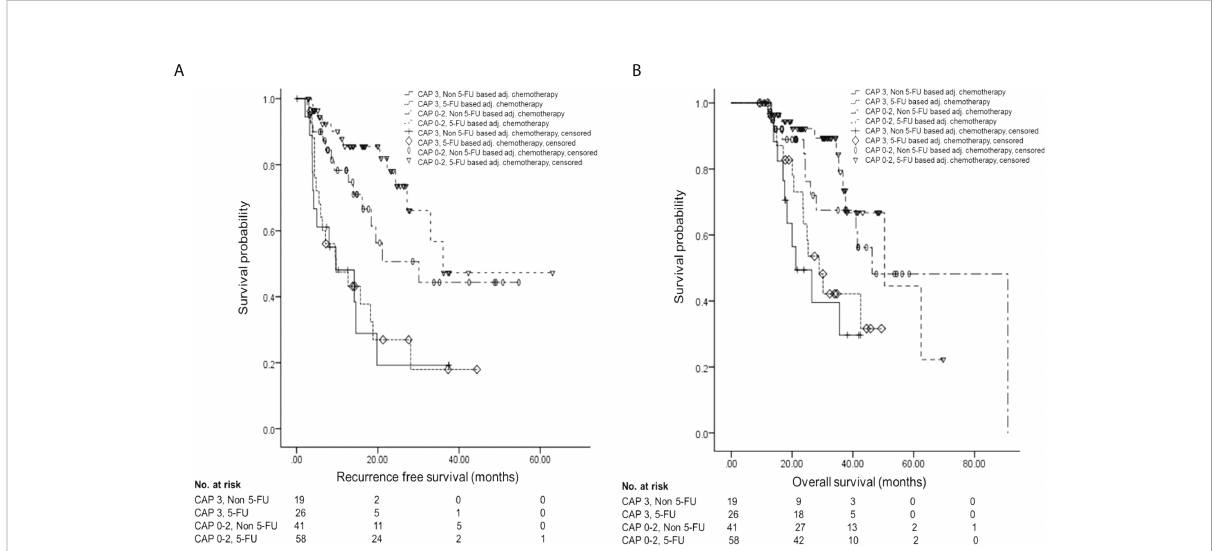
FIGURE 3 Survival analysis by the four groups according to pathologic response and AT regimen. (A) Kaplan – Meier curve of RFS according to groups. (B) Kaplan – Meier curve of OS according to groups. AT, adjuvant therapy; 5-FU, 5- fl uorouracil; RFS, recurrence-free survival; OS, overall